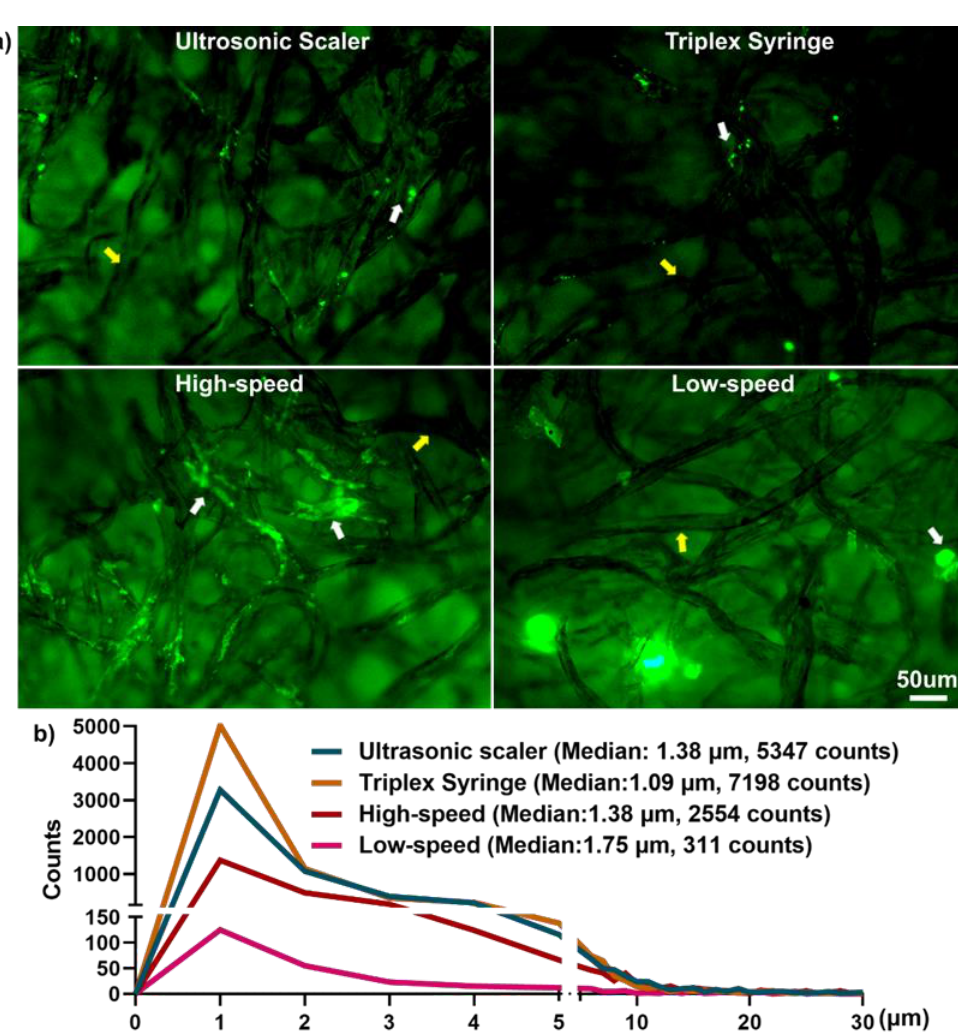
Figure 5. Detection of aerosols and droplets retained in filter paper fibres, at the furthest point from the source. ( a ) Representative fluorescent images of aerosols and droplets generated by four dental procedures. Yellow arrow: paper fibres; white arrow: aerosols/droplets. ( b ) The distribution of aerosols and droplets at location 10.